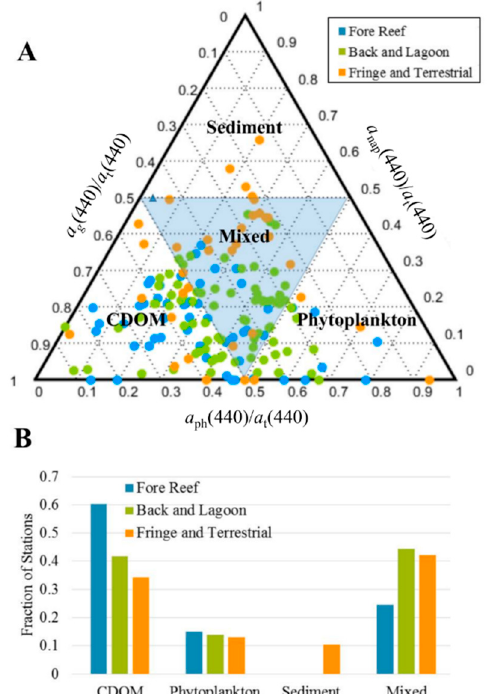
Figure 8. ( A ) Ternary plot showing the fraction of total non-water absorption dominated by colored dissolved organic matter (CDOM) ( a g ), phytoplankton ( a ph ), sediment ( a nap ), and mixed (center triangle) for stations categorized according to the three geomorphic reef zones. ( B ) The fraction of stations from each geomorphic zone where total non-water absorption is dominated by one of the three constituents shown in panel A or mixed between the constituents (center triangle).